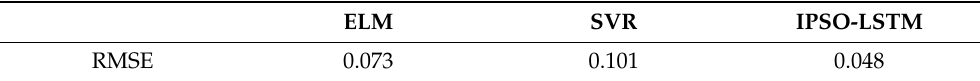
Figure 17. Performance degradation predictions of the roller bearing for the: ( a ) ELM; ( b ) SVR; ( c ) IPSO-LSTM. Table 6. The RMSE of different